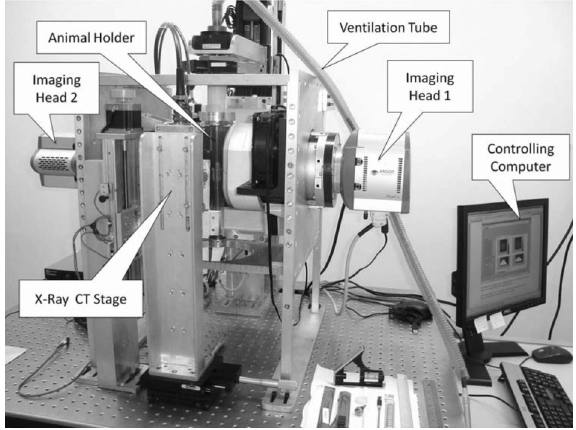
Figure 1. Single photon emission microscope (SPEM). The main components are